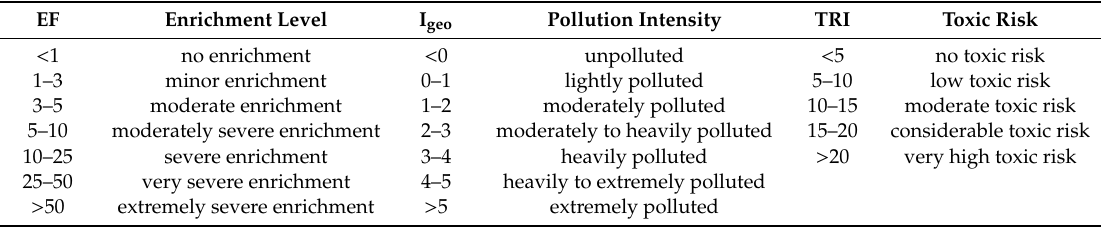
Table 1. Contamination and toxic risk categories based on enrichment factor (EF), geo-accumulation index (I geo ) and toxic risk index